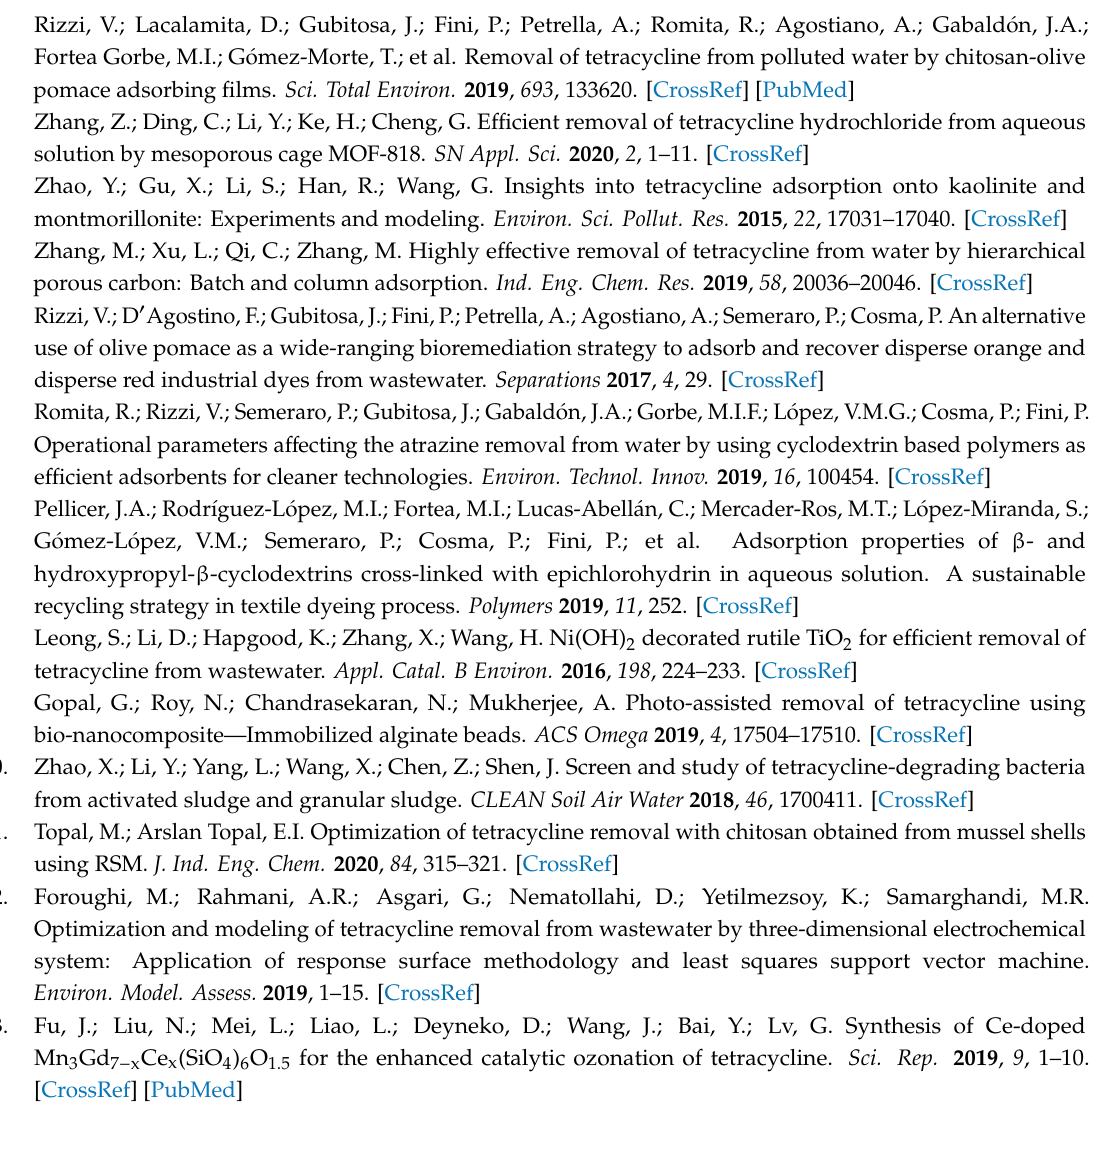
Figure S1: XRF spectra of the ZnO / γ -Fe 2 O 3 composite photocatalyst, Table S1: calculated wt. % of the oxides present in the composite